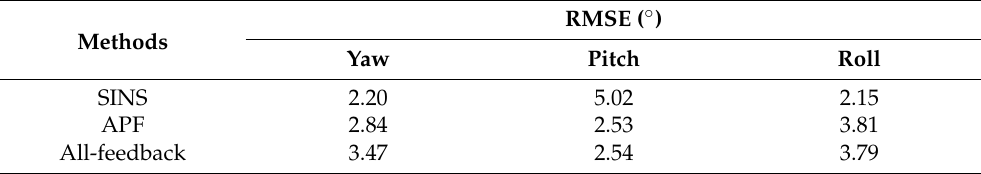
γ x . Figure S3: 3D attitude errors for different γ x . Figure S4: 3D attitude angle estimation curves for different γ y . Figure S5. 3D attitude errors for different γ y . More details of the state transition matrix of the INS error model Φ